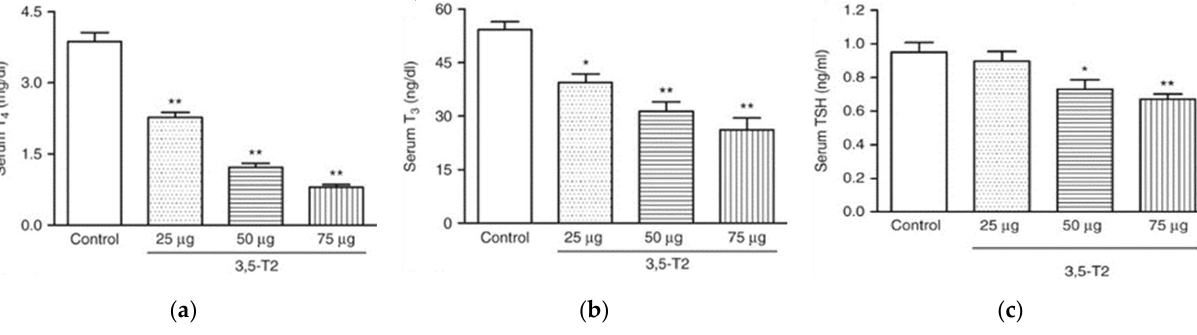
Figure 5. TH profile serum concentrations in adult male Wistar rats treated (or not treated) with 3,5- T2 for 90 days at daily s.c. doses of 25, 50, and 75 µg/100 g BW. Serum TSH, T4, and T3 concentrations were dose dependently suppressed by 3,5-T2 treatment. ( a ) serum total T4 (13–18 rats per group); ( b ) serum total T3 (13–18 rats per group); ( c ) serum TSH (11–14 rats per group). * p < 0.01 vs. control group; ** p < 0.001 vs. control group. Reprinted with permission from Ref . [39] , © 2014, The authors. 3,5-T2 is known to bind to the TR with a lower affinity compared to T3. However, similar effects of the high 3,5-T2 dose and T3 indicate at least a partial action of 3,5-T2 via the (canonical) nuclear pathways. Therefore, 3,5-T2 at higher concentrations than T3 may act as a potential ligand for at least some TR isoforms. These observations highlight the